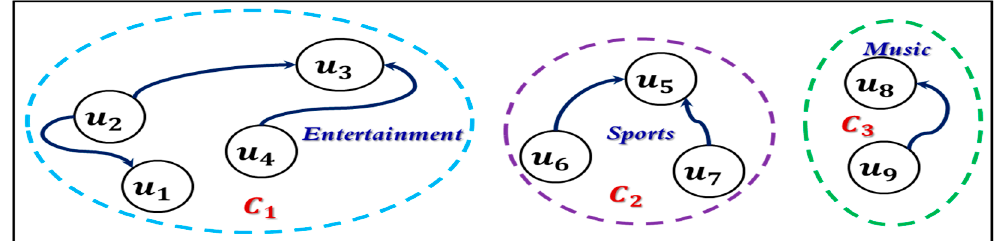
Figure 27. Information diffusion in a SN via communities.